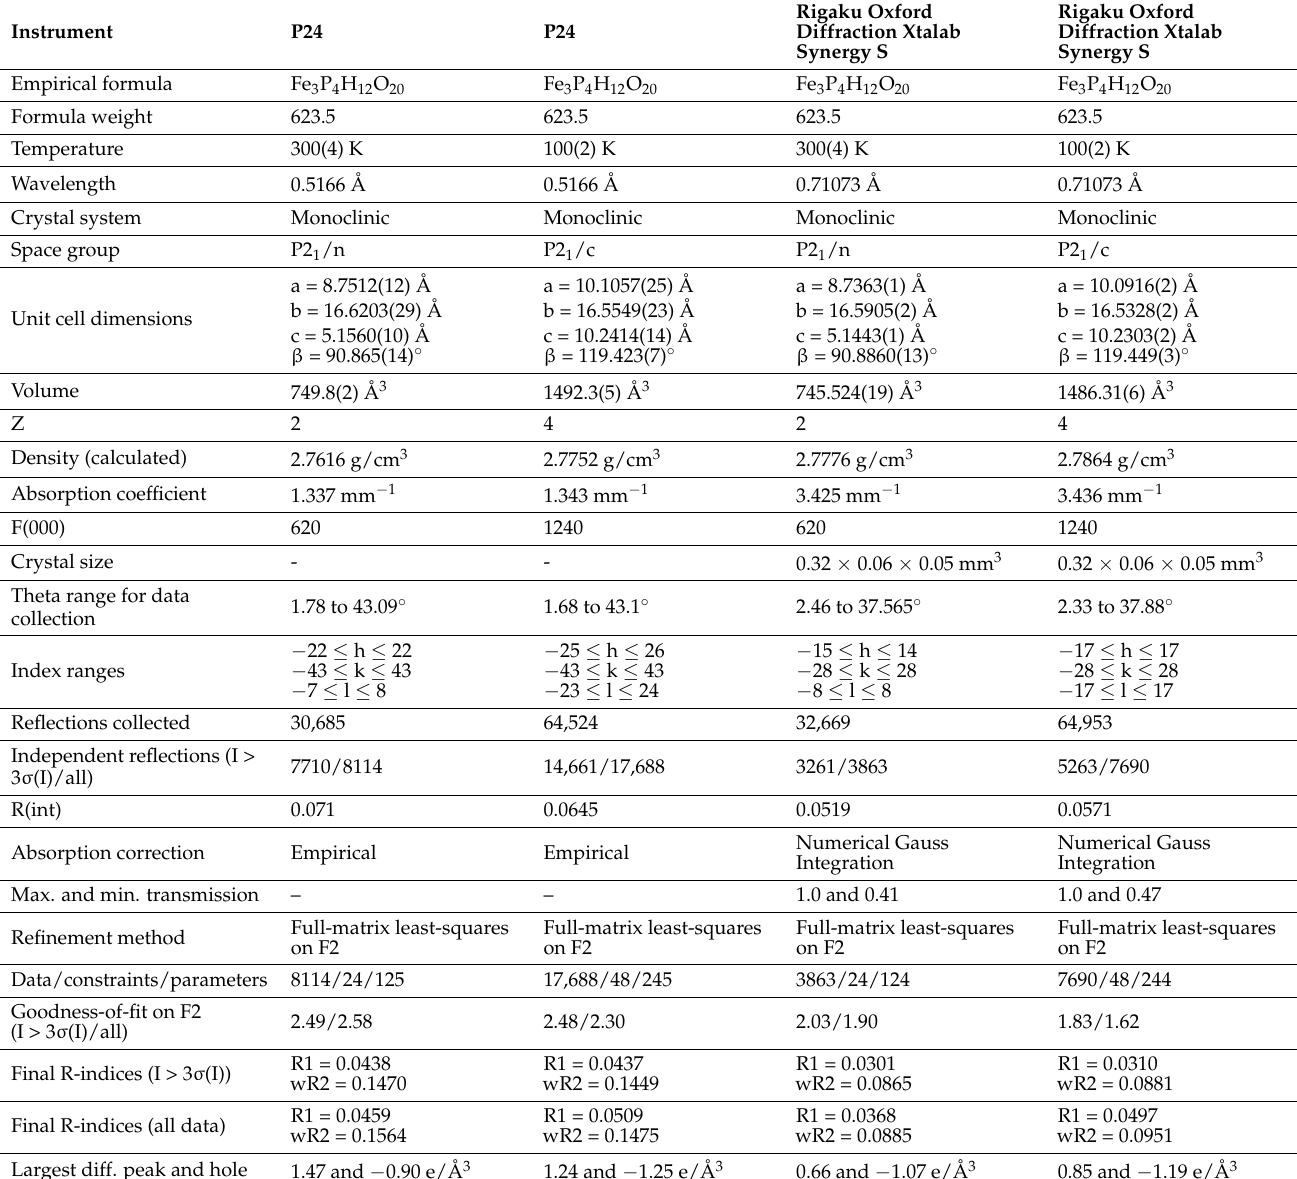
Table 1. Data collection statistics at 300 K and 100 K from the P24 and Rigaku Oxford Diffraction instruments; 1st column provides the name of the physical quantities used to described the experiment and data analysis, 2nd and 3rd columns provide the values to the physical quantities from the P24 instrument, while the 4th and 5th columns list the values from the laboratory